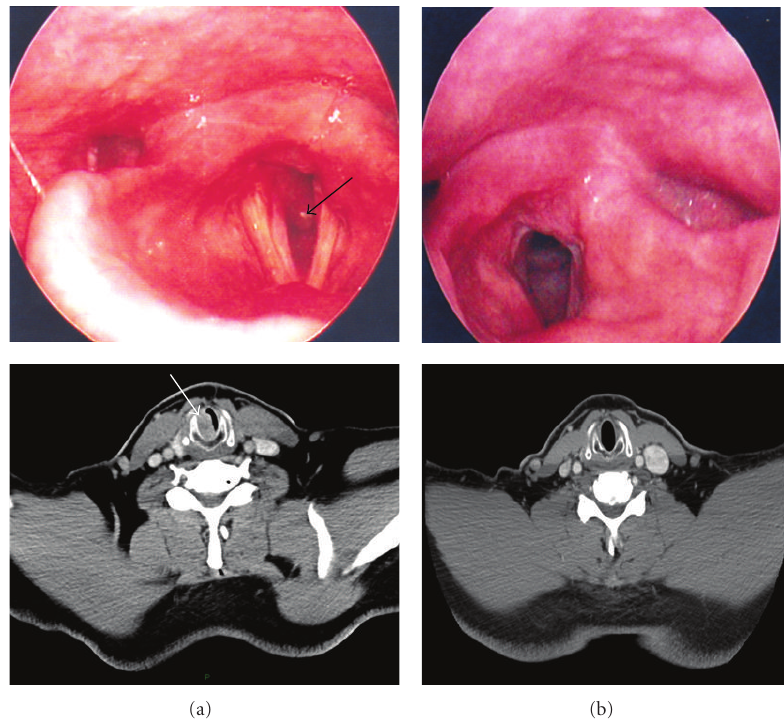
Figure 1: (a) At the top there is an image obtained by indirect laryngoscopy (IL) revealing severe edema of the posterior commissure and a polypoid mass on the right posterolateral subglottic wall (arrow). At the bottom there is an axial image of computer tomography (CT) at the cricoid cartilage level that shows a homogenous image with contrast enhancement at the subglottic submucosal region (arrow). (b) At the top there is an image obtained by IL 6 months after the treatment was finished. It shows absence of the subglottic mass. At the bottom there is an axial CT image at the cricoid cartilage level that reveals 100% free subglottic